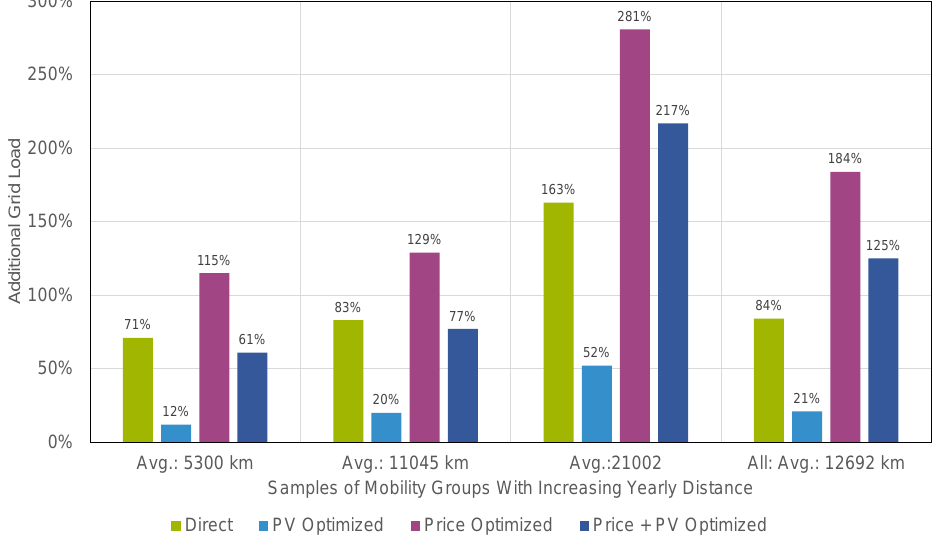
Figure 24. Largest 1% values of additional grid load for three samples with different annual